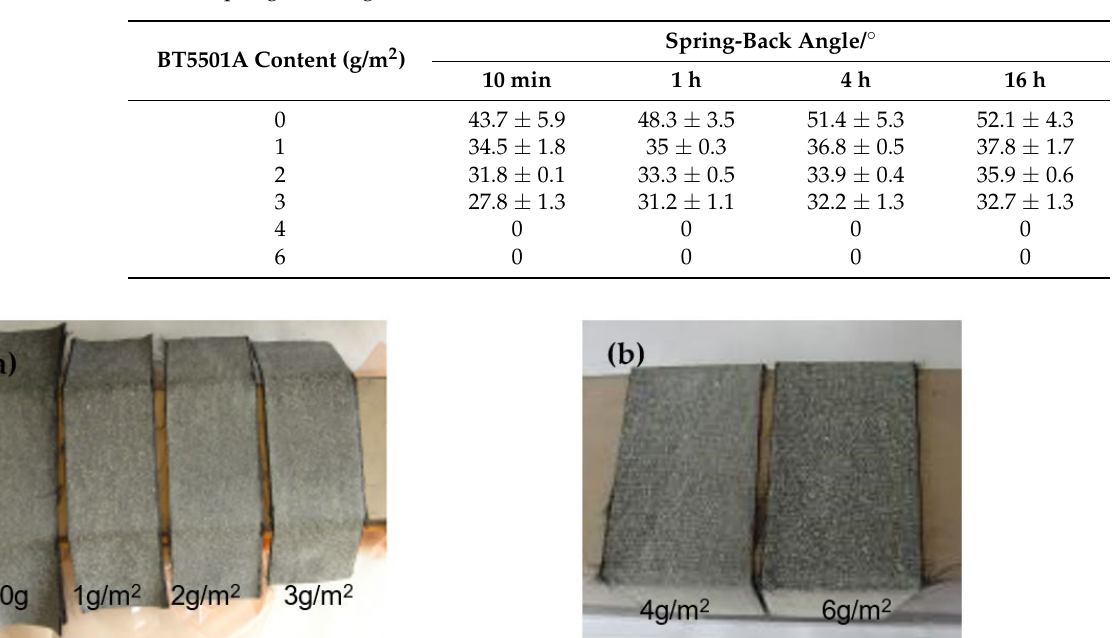
Table 1. Spring-back angles of the bifunctional CF fabrics treated at 80 °C/45min in vacuum.